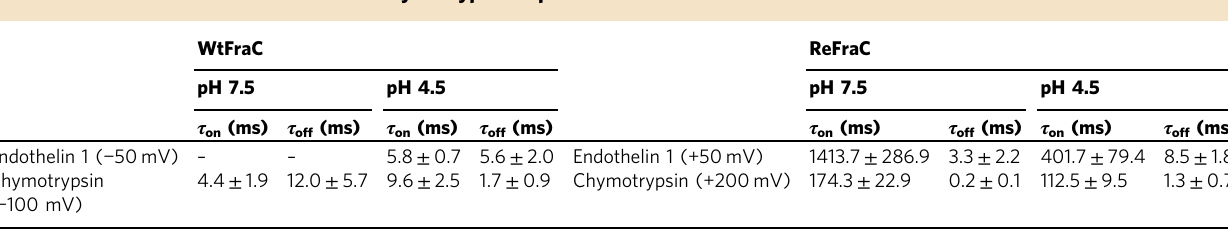
Table 1 Parameters of endothelin 1 and chymotrypsin captured with WtFraC and